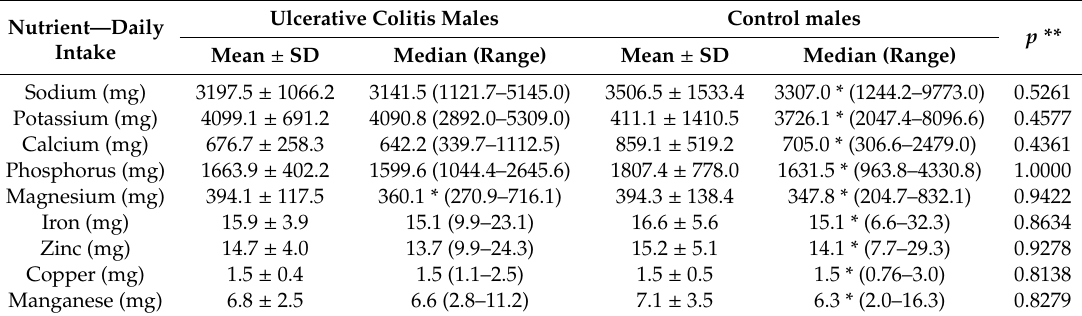
Table 3. The minerals intake in ulcerative colitis males and control males.